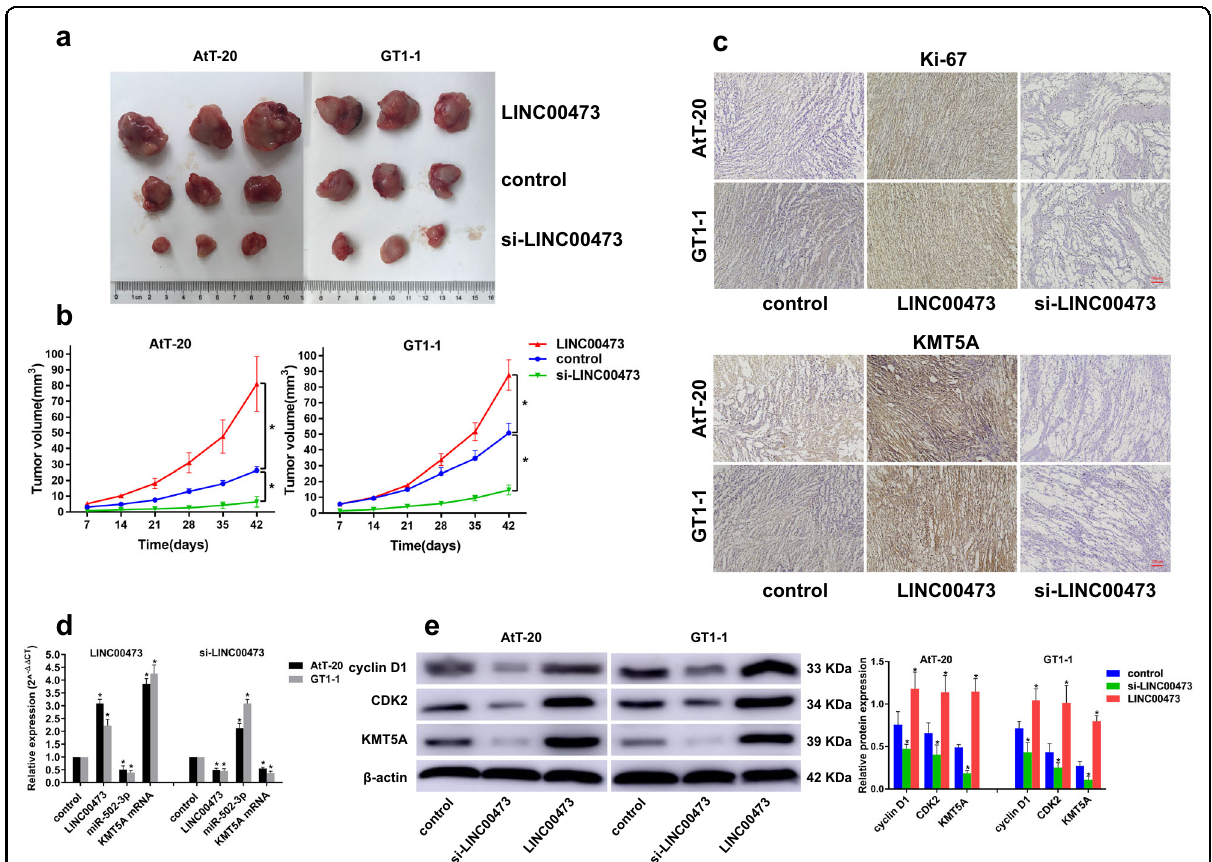
Fig. 6 LINC00473 promotes the growth of PA in vivo. a Images of tumors formed in nude mice injected subcutaneously with PA cells (overexpression, control, or knockdown of LINC00473) were shown. b The volume of subcutaneous xenograft tumors. c Ki-67 and KMT5A immunohistochemical staining. d qRT-PCR was used to detect the expression of LINC00473, miR-502-3p, and KMT5A mRNA in tumor tissues after overexpression or knockdown of LINC00473. e Western blot analysis of cyclin D1, CDK2, and KMT5A expression in tumor tissues. * P < 0.05, ** P < 0.01, data represent the mean ±